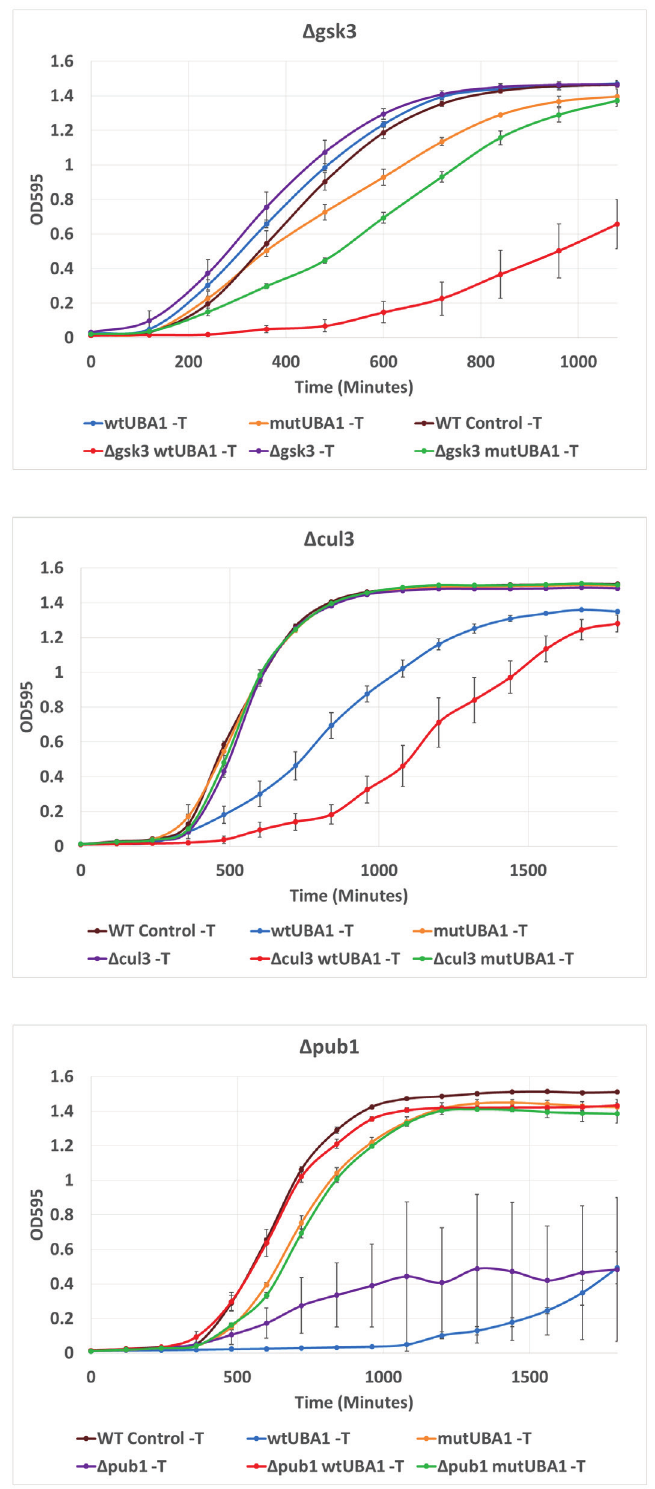
Figure S4. Validation of SGA data for cul3 , pub1 and gsk3 . Growth curves of the 3 double mutants confirmed our original SGA data showing that the deletions of cul3 and gsk3 are synthetically lethal with OE of UBA1 , and the deletion of pub1 ( NEDD4 ) suppresses the toxicity associated with OE of wildtype UBA1 . For gsk3 and cul3 , the cells were washed to remove thiamine and immediately placed in the plate reader whilst for pub1 , cells were first pre-induced for 22 hrs. Deletions of cul3 , pub1 , and gsk3 were confirmed by PCR.